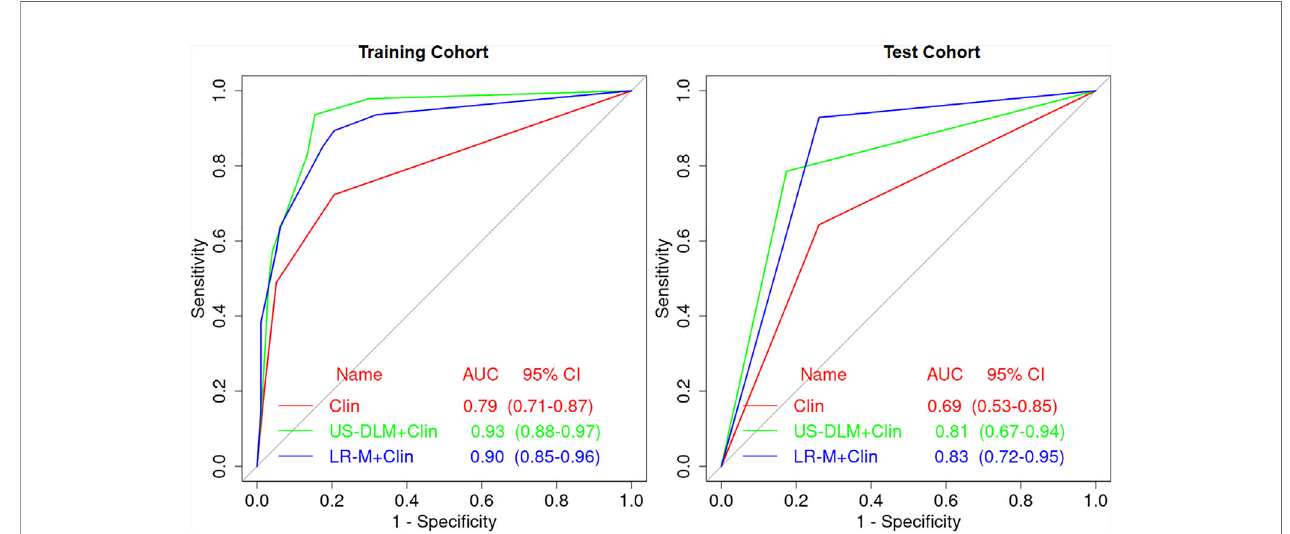
FIGURE 4 | Receiver operating characteristic curves of different predictive nomogram models for predicting OM in training and test cohort in cirrhotic liver. Clin, clinical features; DLM, deep learning model; LR-M, liver imaging and reporting system category.